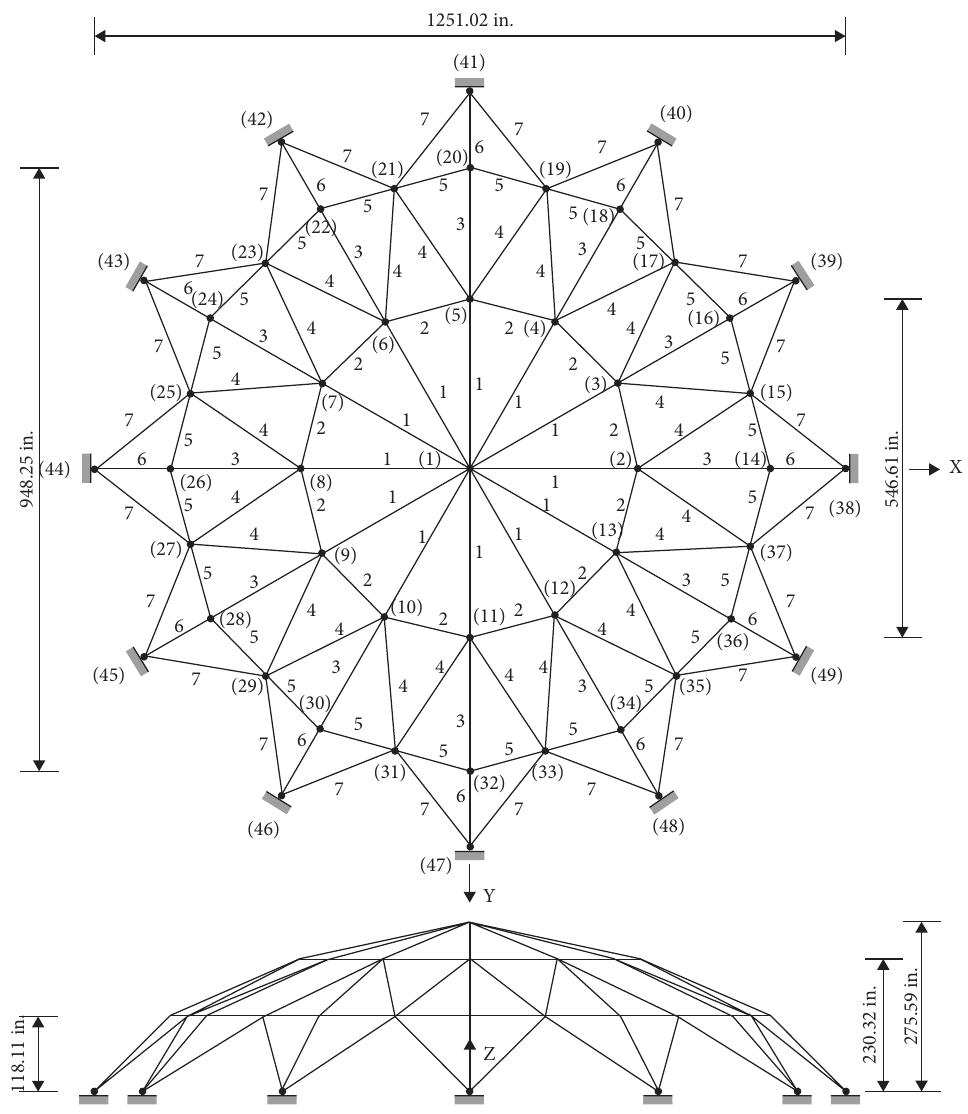
Figure 12: Configuration of the 120-bar truss (reproduced from Lee and Geem [1], under the Creative Commons Attribution License/ public